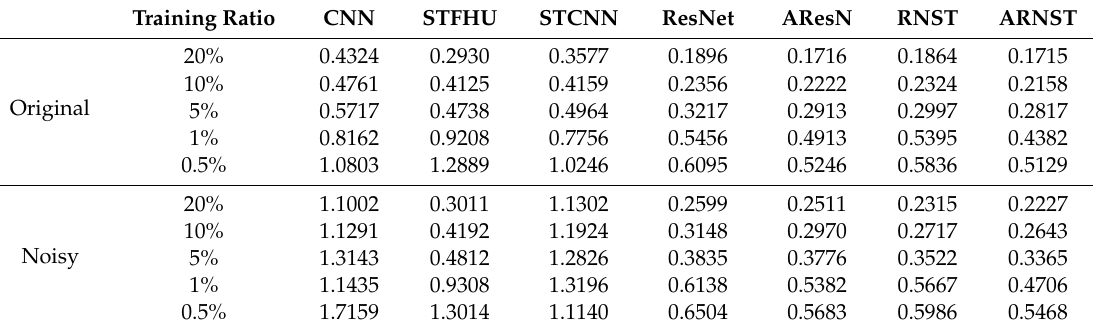
Table 3. Summations of RMSE with small training ratios for the Urban hyperspectral dataset. Training Ratio